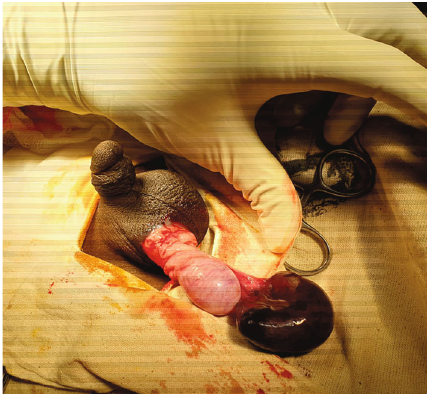
Figure 2: Twisted right Epididymal cyst with normal testis.